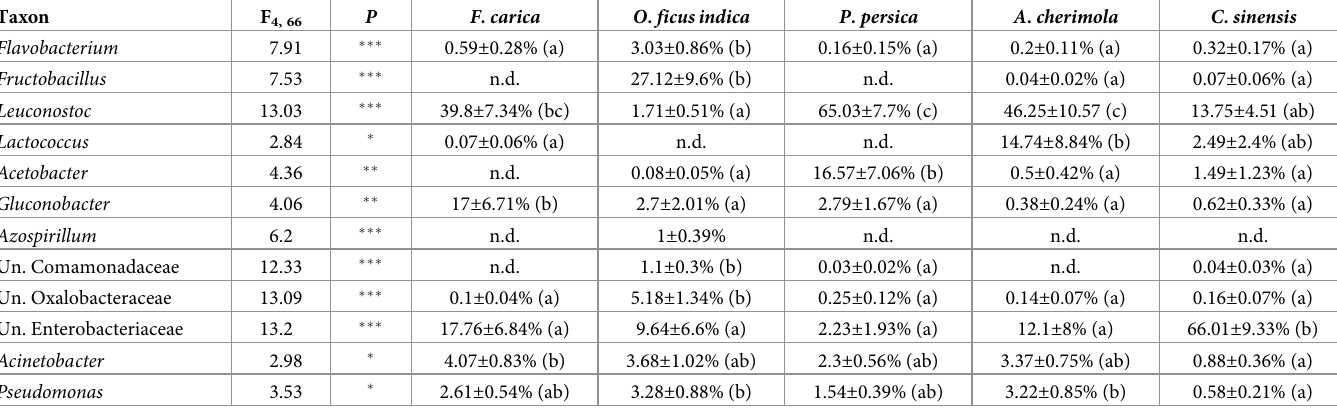
Table 2. Bacterial taxa differentially associated with larvae of C . capitata feeding on different host